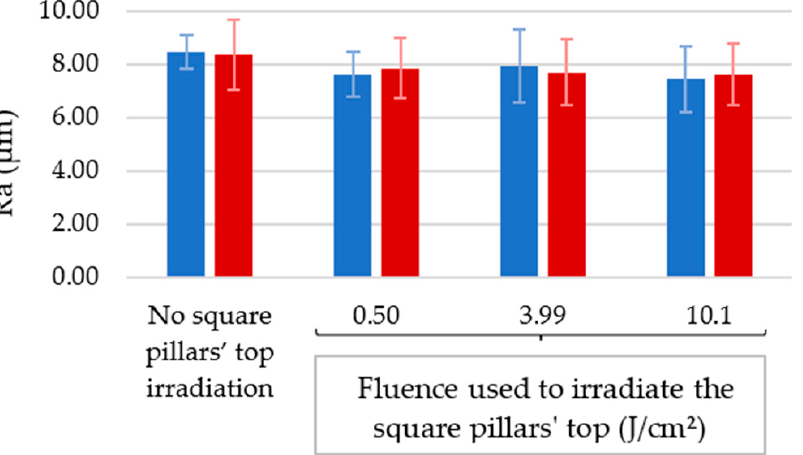
Figure 9. Unfiltered profile of the sample for which the square pillars’ top was not irradiated. From Figure 10, we note that Ra values in the micrometric scale are similar independent of the fluence used to irradiate the square pillars’ top and of the texturing environment (8.1 ± 0.1 µ m). We note a slight decrease with increasing fluence, which is consistent with the dimensions of the square pillars just detailed.